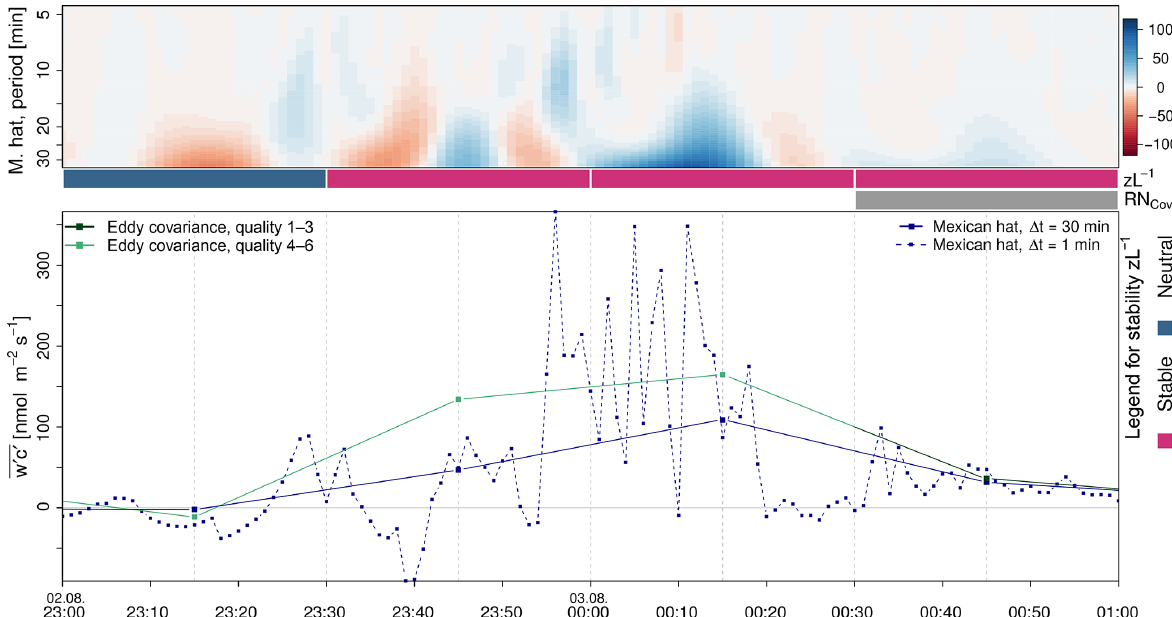
Figure 3. Wavelet cross-scalogram and flux rates computed for tower 1 during the case study event on 2–3 August 2014. The colours in the wavelet cross-scalogram between w and c denote the flux intensity (wavelet coefficient), where intensive colours indicate higher flux contributions downwards (negative, dark red) or upwards (positive, blue). The whole scalogram is outside the cone of influence (COI). Atmospheric stratification zL − 1 (Foken et al., 2004) for every 30min interval was denoted as a blue (neutral) or pink (stable) colour bar right below the cross-scalogram. Grey-coloured intervals in the line labelled RN Cov refer to best steady-state (RN Cov < 30%) conditions according to Foken et al. (2004). The quality classes 1–9 in the bottom panel for EC refer to the overall flux flagging system after Foken et al.